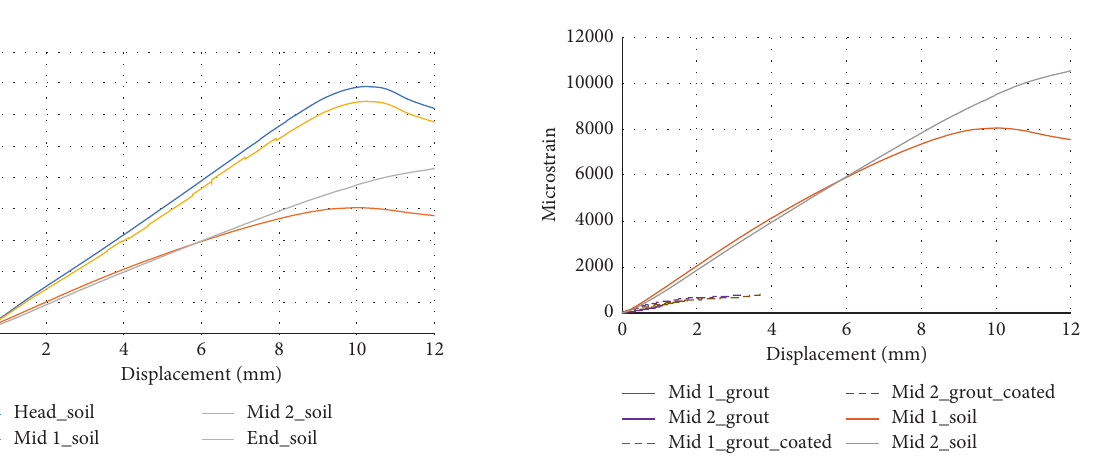
Figure 25: Strain vs. displacement at midpoints for uncoated GFRP rock bolt sensors fixed with grout and soil and coated GFRP rock bolt sensor fixed with